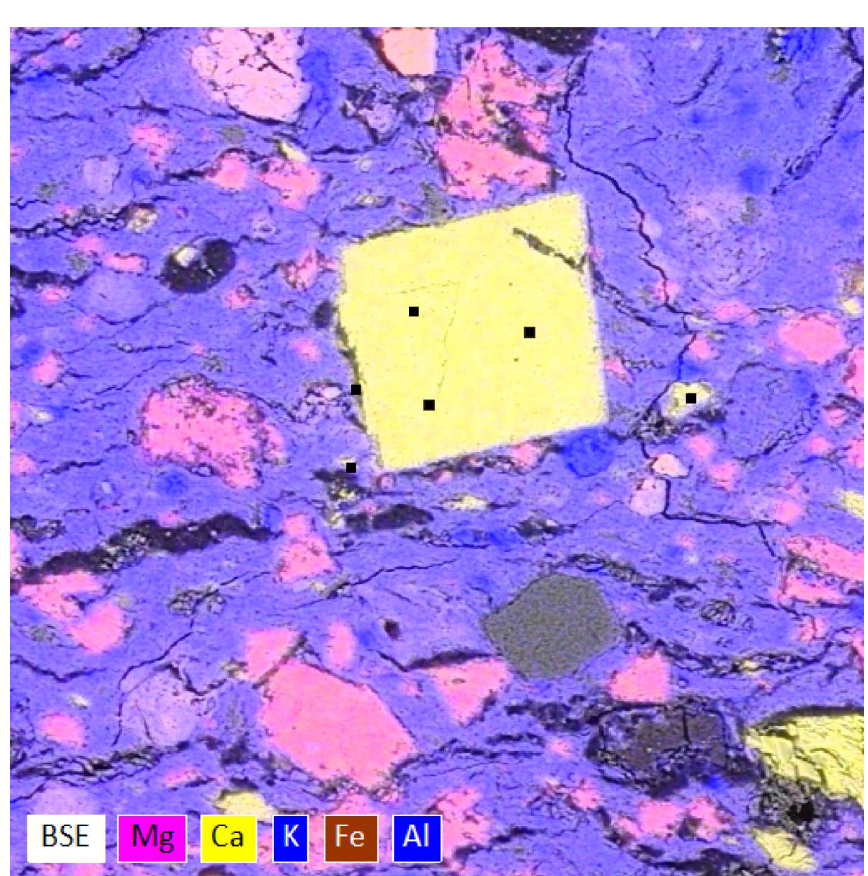
Figure 10. EDS elemental distribution map of a large calcite grain in sample M46. Black squares are locations of spot analyses for both the mineral grain and secondary calcite leaching. Mg and Fe concentrations are related to very small ferromagnesian minerals (amphiboles and pyroxenes) within the ceramic fabric. Ca distribution is noted only on calcite grains and clay matrix. Backscattered electron micrograph taken at 250 × magnification by William